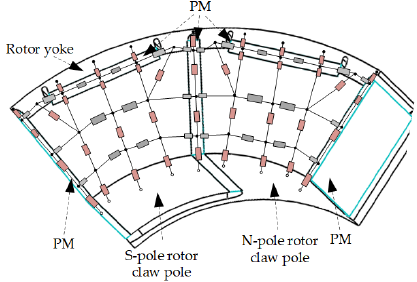
Figure 6. The thermal network model of DHEG rotor part.